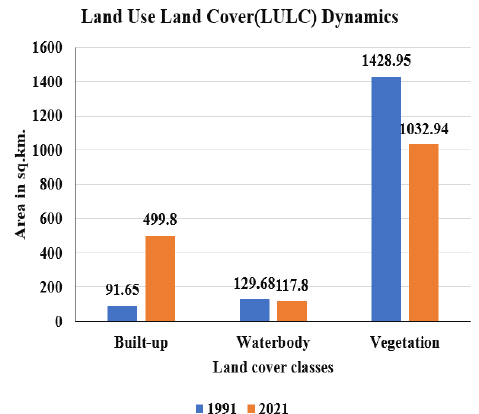
Figure 5 : Land use land cover dynamics during